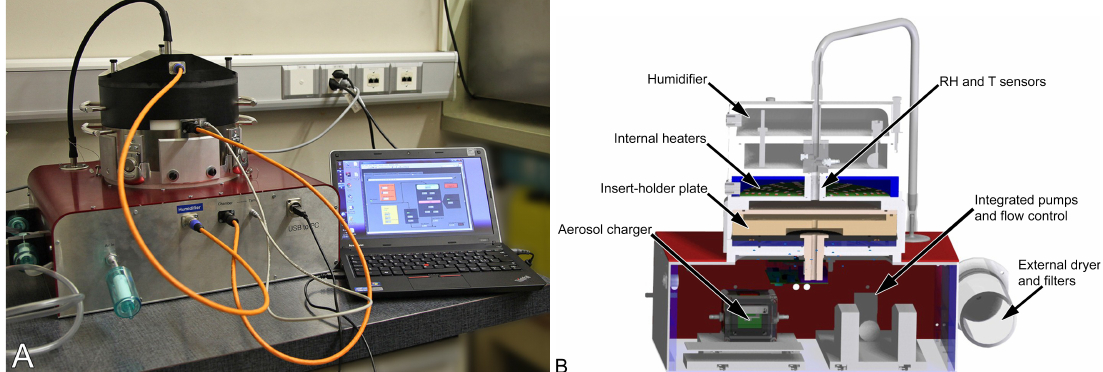
Figure 1. Nano Aerosol Chamber for In Vitro Toxicity (NACIVT). ( A ) Picture of chamber with dedicated laptop and LabVIEW software; ( B ) schematic section showing and describing the main parts of the chamber.